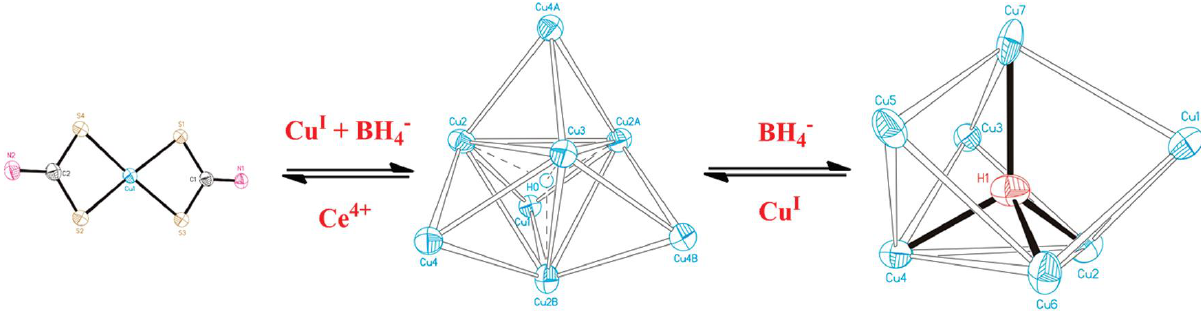
Figure 12. Interconversion of [Cu(S 2 CNR 2 ) 2 ] with [Cu 8 H( µ -S 2 CNR 2 ) 6 ] + and [Cu 7 H( µ 3 -S 2 CNR 2 ) 6 ] upon addition of [BH 4 ] − and oxidation, respectively. Reproduced with permission from [108]. Copyright 2012 American Chemical Society.